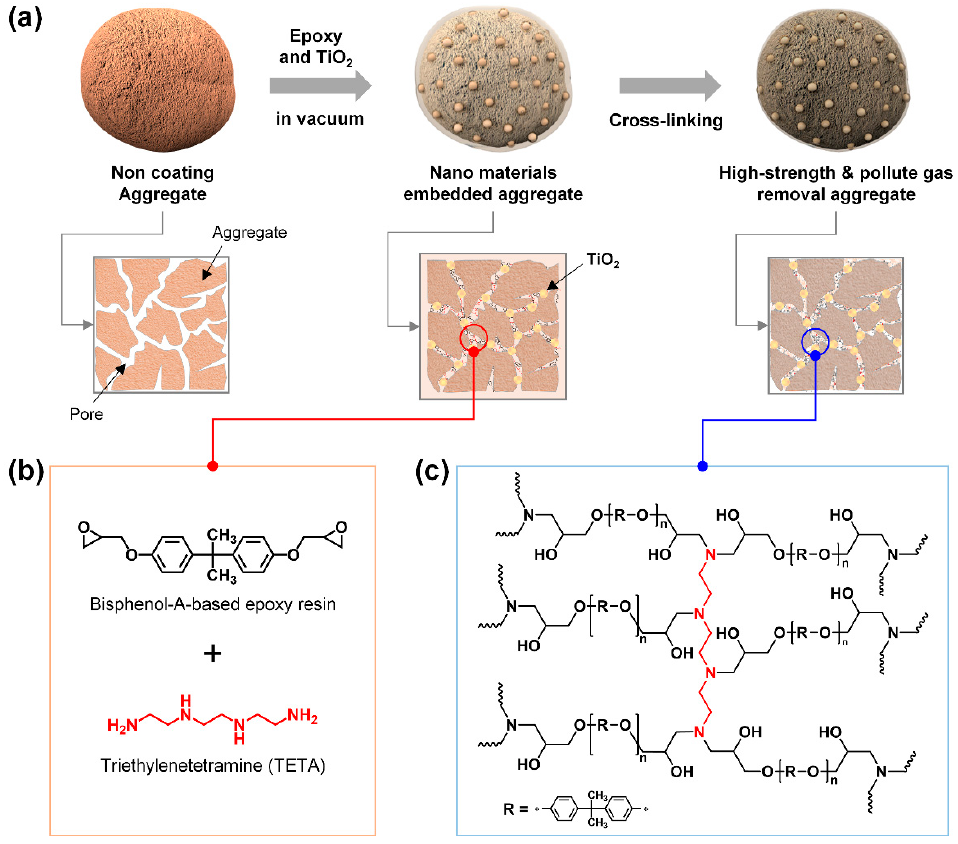
Figure 1. Fabrication of an epoxy–TiO 2 -embedded lightweight aggregate (LWA). ( a ) Schematic diagram of embedding hyper-crosslinked epoxy into the LWA. ( b ) Chemical structure of the epoxy resin and the crosslinker being filled into the pores of the LWA. ( c ) Chemical structure of the post-crosslinked epoxy polymer.